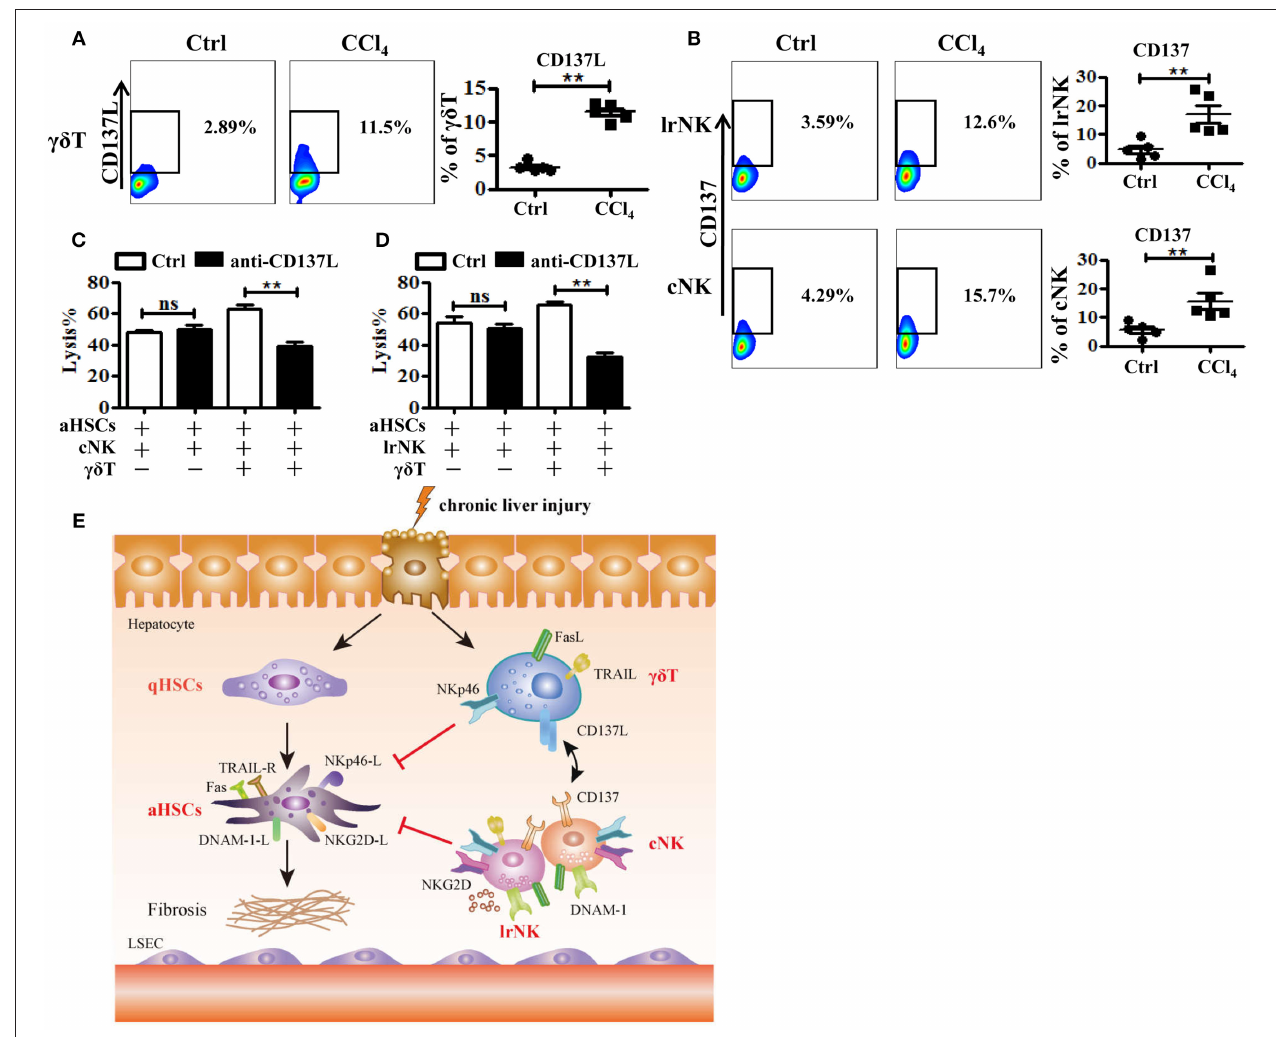
FIGURE 8 | The crosstalk between γδ T cells and cNK cells as well as lrNK cells. (A) Liver mononuclear cells were isolated from WT mice with or without CCl 4 continuous administration, respectively. (Left) The expression of CD137 ligand (CD137L) on hepatic γδ T cells was determined by FACS. (Right) Statistical analysis is shown, n = 6. (B) (Left) The expression CD137 on hepatic cNK and lrNK cells was determined by FACS, respectively. (Right) Statistical analysis is shown, n = 6. (C, D) The culture-activated HSCs were co-cultured with isolated hepatic lrNK cells or cNK cells with/without γδ T cells at an effector:target ratio of 2:1 in the present or absence of CD137L-specific blocking antibody (anti-CD137L) for 12h, respectively. The cytotoxicity against activated HSCs was determined using LDH assay. (E) Schematic model for the anti-fibrotic functions of hepatic γδ T cells in CCl 4 -induced liver fibrosis, through directly killing against activated HSCs dependent on NKp46-mediated cytotoxicity, and increasing NK cells-mediated cytotoxicity against activated HSCs through CD137-CD137L interaction in CCl 4 -induced liver fibrosis. ** P <